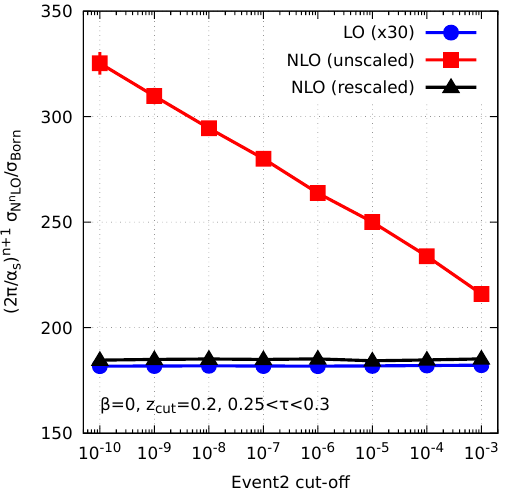
Figure 10. Illustration of the collinear divergence for unscaled soft-drop thrust using EVENT2